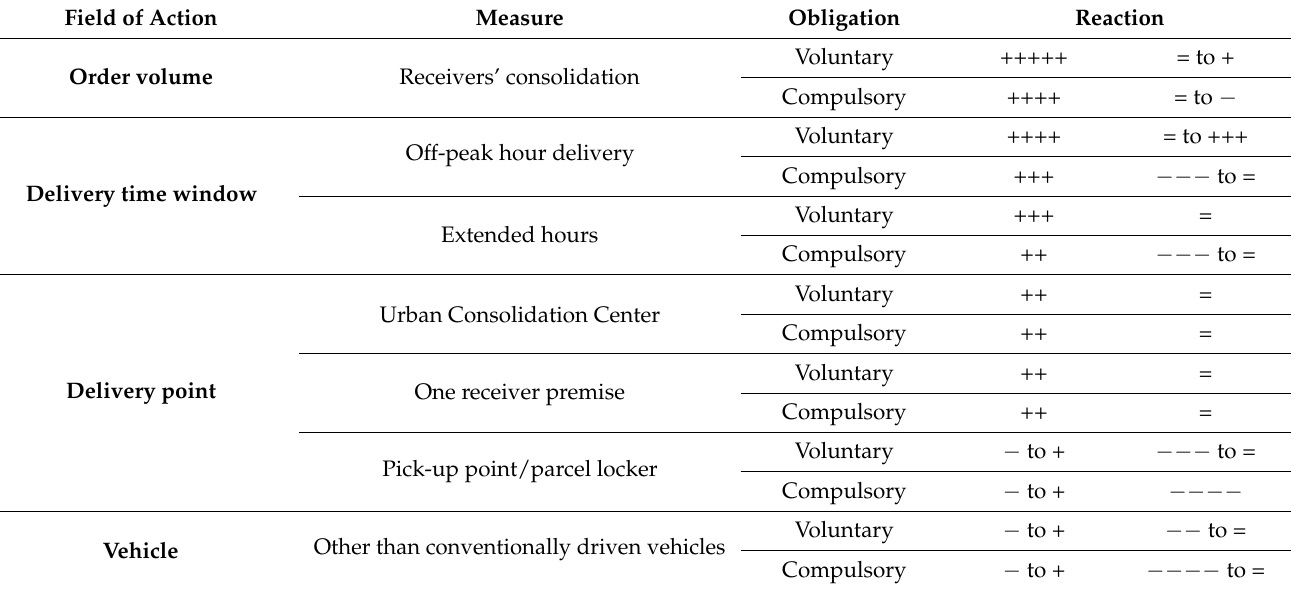
Table 1. Review of methods for the demand management and their impact